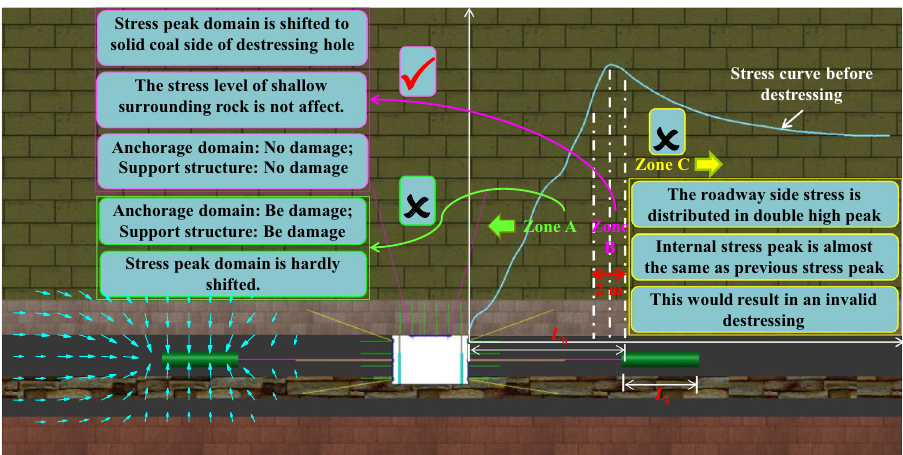
Figure 11. Schematic of L h